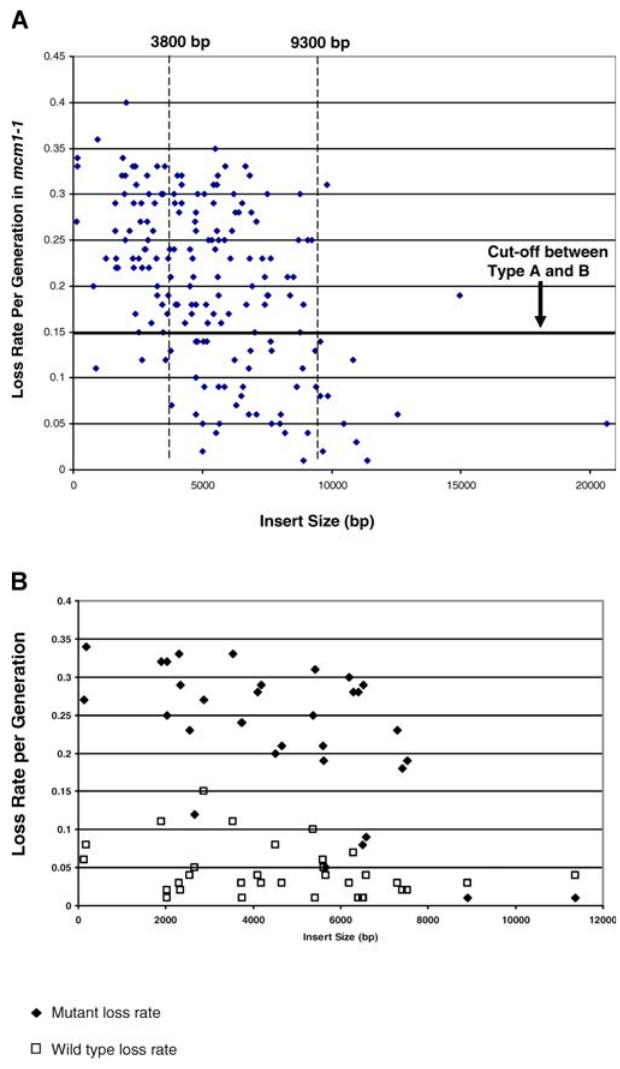
Figure 3. Characterization of A-Type and B-Type ARSs (A) Effect of insert size on plasmid stability. Loss rates of plasmids per cell division in mcm1–1 cells plotted against insert size. Only inserts between 3,800 and 9,300 bp were analyzed further. (B) Stability of plasmids was measured in mutant (black diamonds) and wild-type (white squares) cells. DOI: 10.137/journal.pgen.0020141.g003